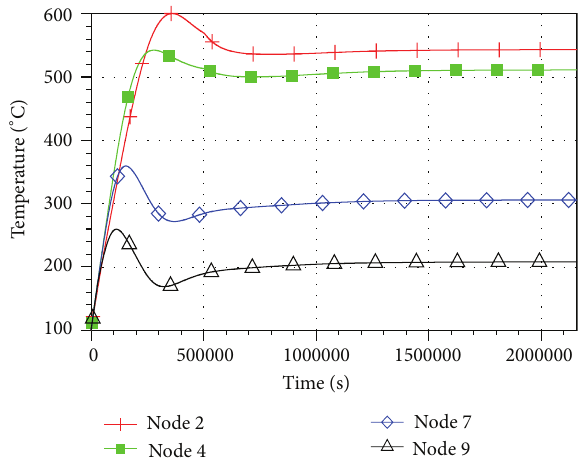
Figure 10: Temperatures of fuel in fuel assemblies